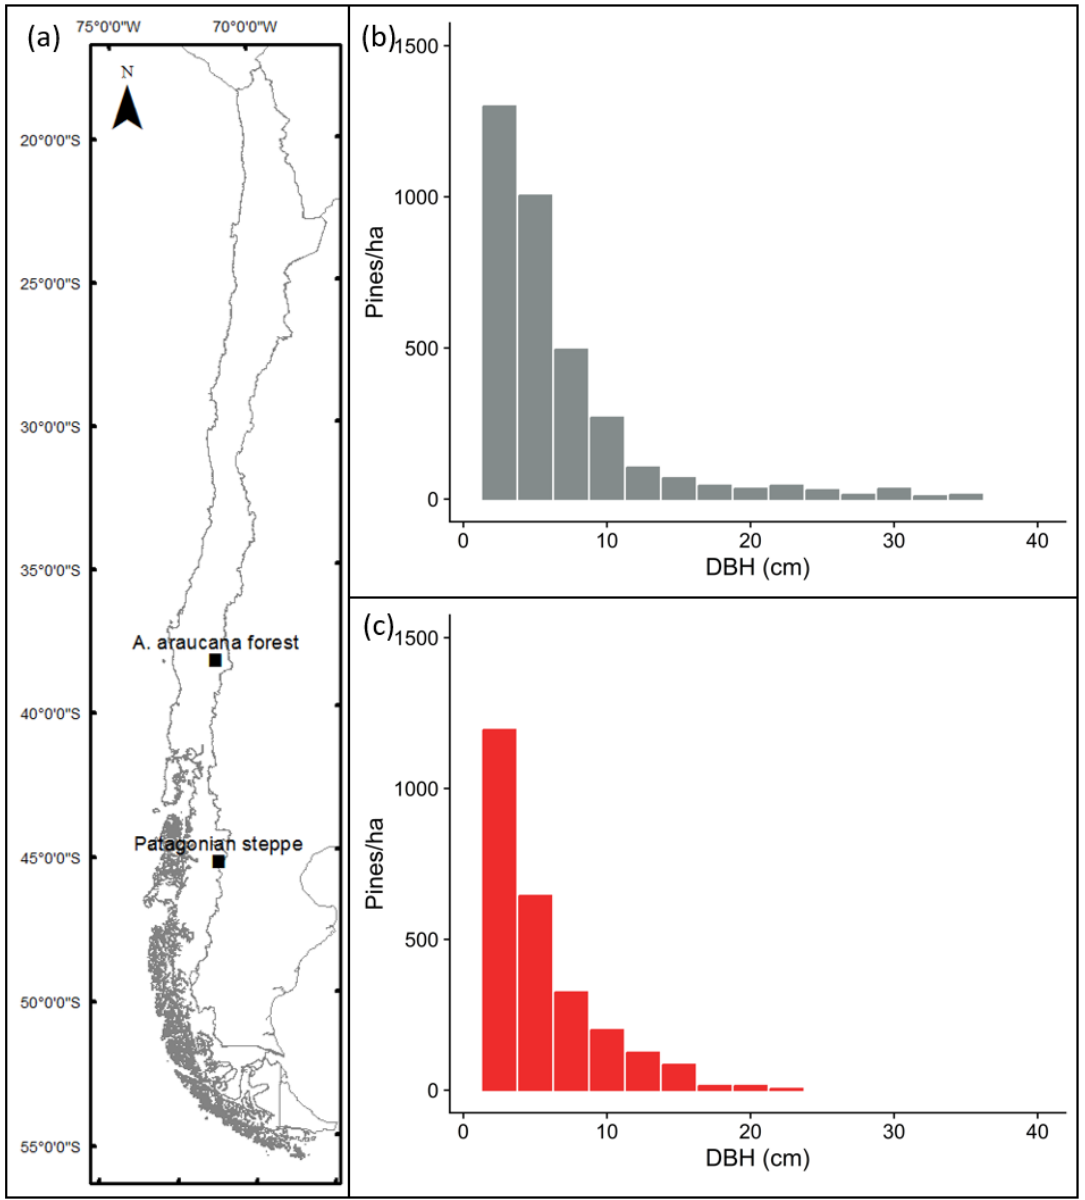
Figure 1. Location of the study sites in the Malalcahuello National Reserve ( A. araucana forest) and Coyhaique Alto (Patagonian steppe) ( a ). Average diametric distribution (pines > 1 m) along the invasion gradient for A. araucana forest ( b ) and Patagonian steppe ( c ) ecosystems.